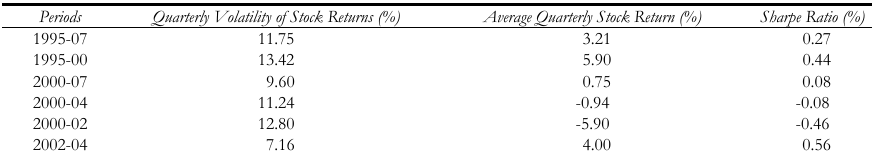
Volatility and Stock Returns The table reports the quarterly volatility of stock returns, the average quarterly stock return and the relative Sharpe ratio. Our elaboration based on data drawn from